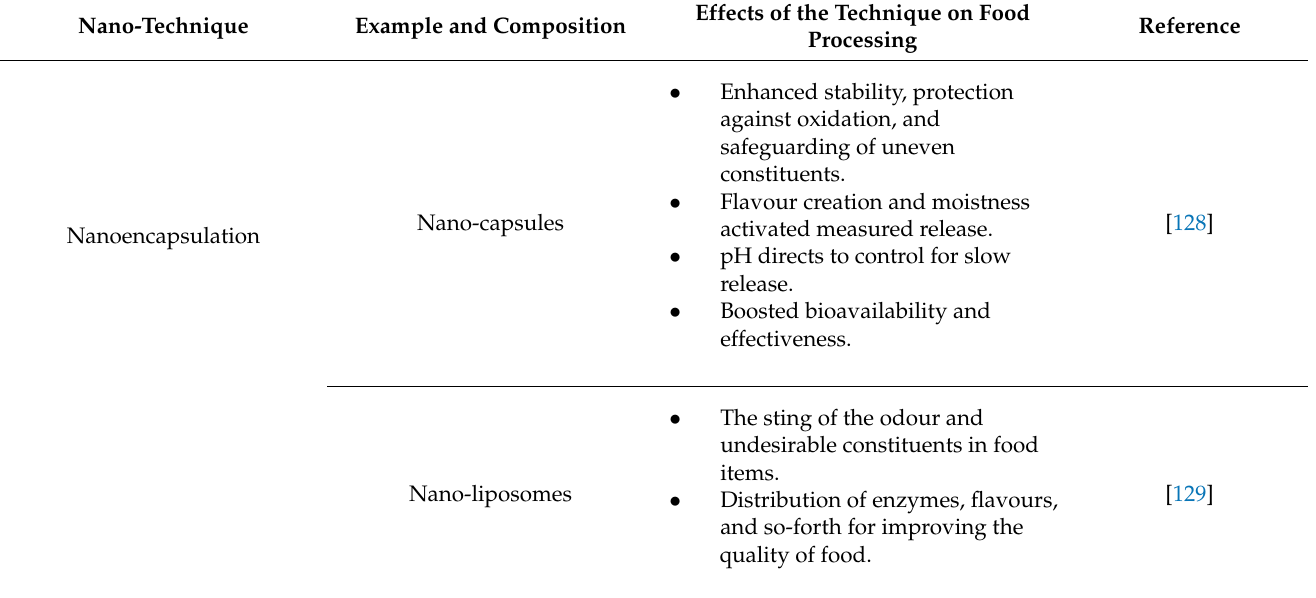
Table 4. Roles and mechanisms of nanomaterials for the enhancement of food processing.